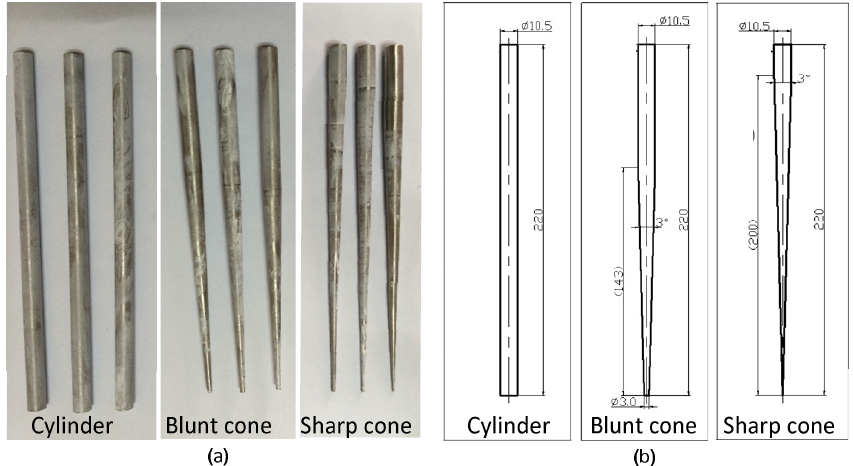
Figure 3. ( a ) Structure and ( b ) dimension of different types of stainless steel